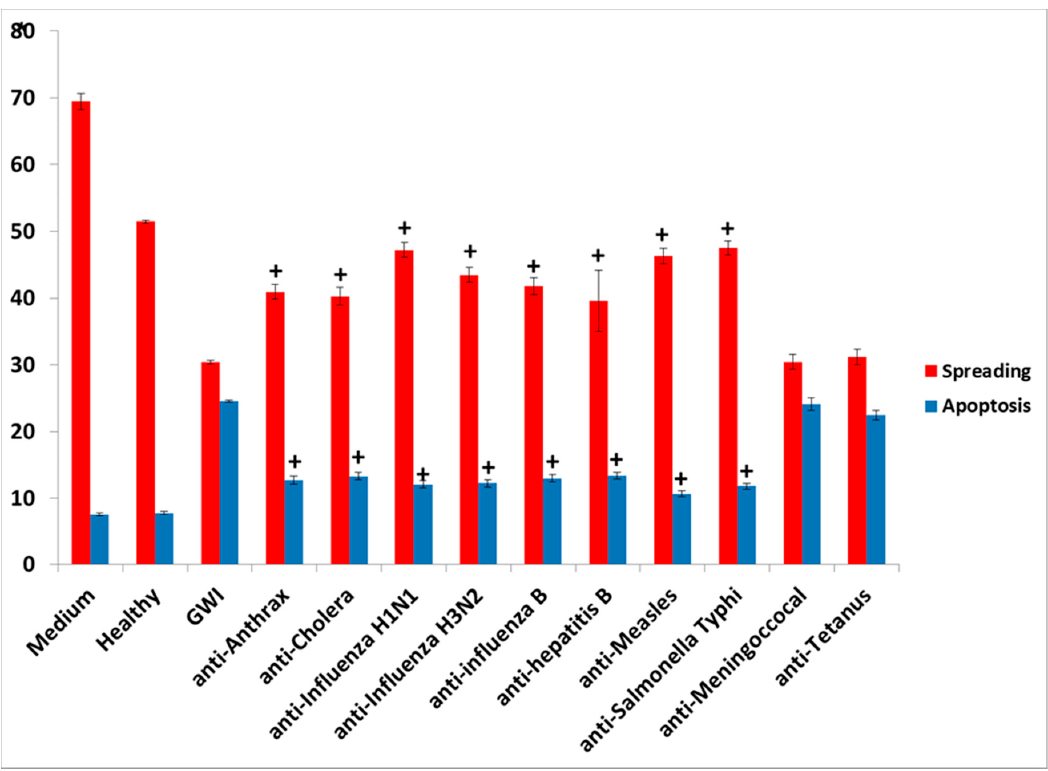
Figure 8. Combined spreading and apoptosis data analysis from all 15 GWI sera in cultured N2A cells; shown are the effects on N2A cells of GWI sera incubated in the presence of each of eight protective antibodies compared to GWI ( + p < 0.0001). Two examples are also shown of GWI sera incubated with anti ‐ vaccine antibodies without a protective effect on cell spreading and apoptosis (anti ‐ meningococcal, anti ‐ tetanus), when compared to GWI.